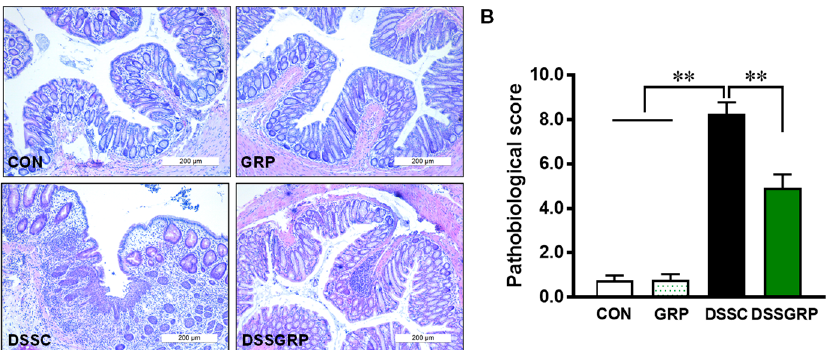
Figure 2. GRP supplementation decreases pathological scores in the colonic tissues of mice. ( A ) Rep- resentative hematoxylin and eosin staining. ( B ) The pathological score of distal colonic tissues. CON: Control, GRP: Sulforaphane glucosinolate, DSSC: DSS-treated control mice, DSSGRP: DSS-treated mice with GRP supplementation. n = 8–9 mice per group. ** p ≤ 0.01.